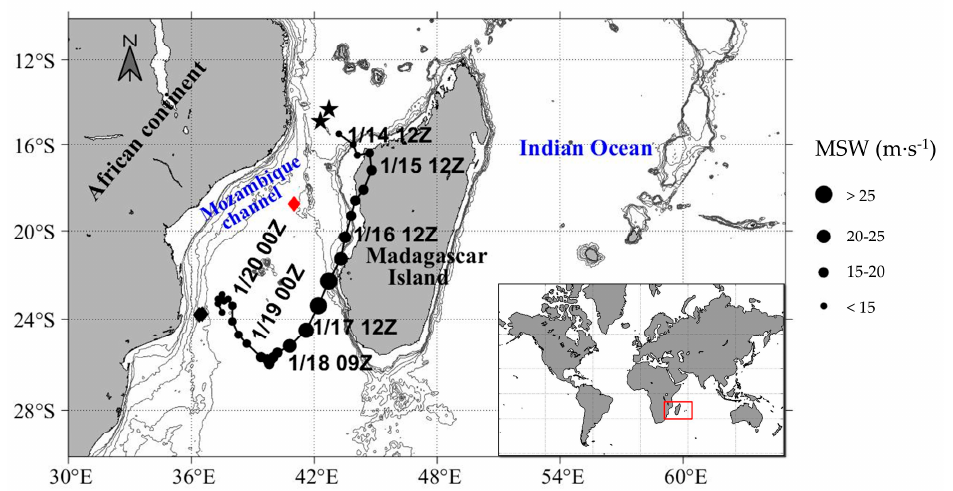
Figure 1. Map of the study area with track of Deliwe (14–20 January 2014) in the Mozambique Channel. The position of the TC center is represented by a black circle and the circle size represents the maximum wind speed. The Argo floats are represented by pentacle (1900270) marks, the CTDs are represented by diamond (1901337) marks, and the red diamond shows the reanalysis data. The inset shows the geographical location of the Mozambique Channel.